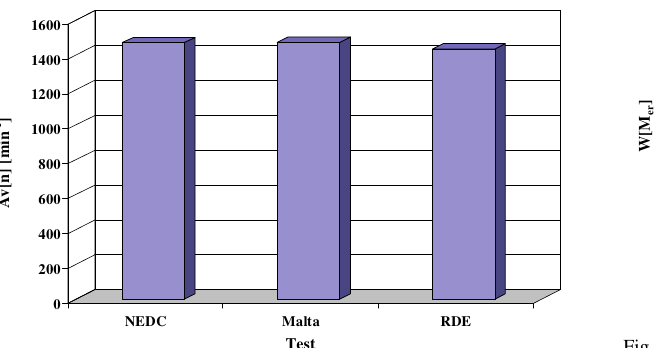
Fig. 10. Average engine speed value in NEDC, Malta and RDE tests